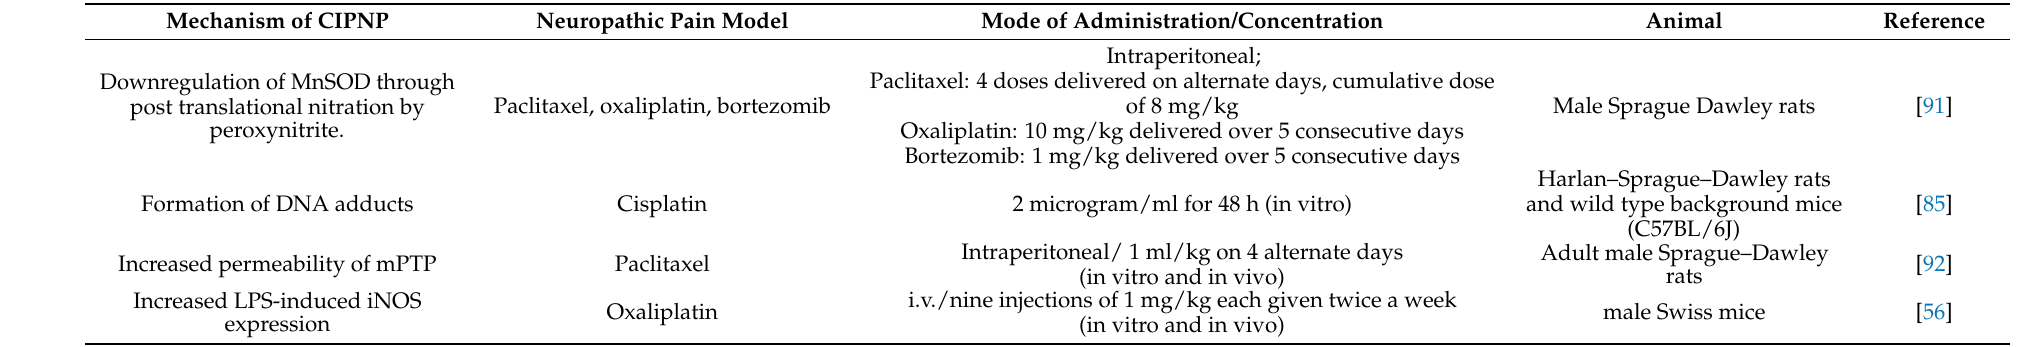
Table 9. Previous studies investigating the mechanisms by which anticancer drugs exert their effects.